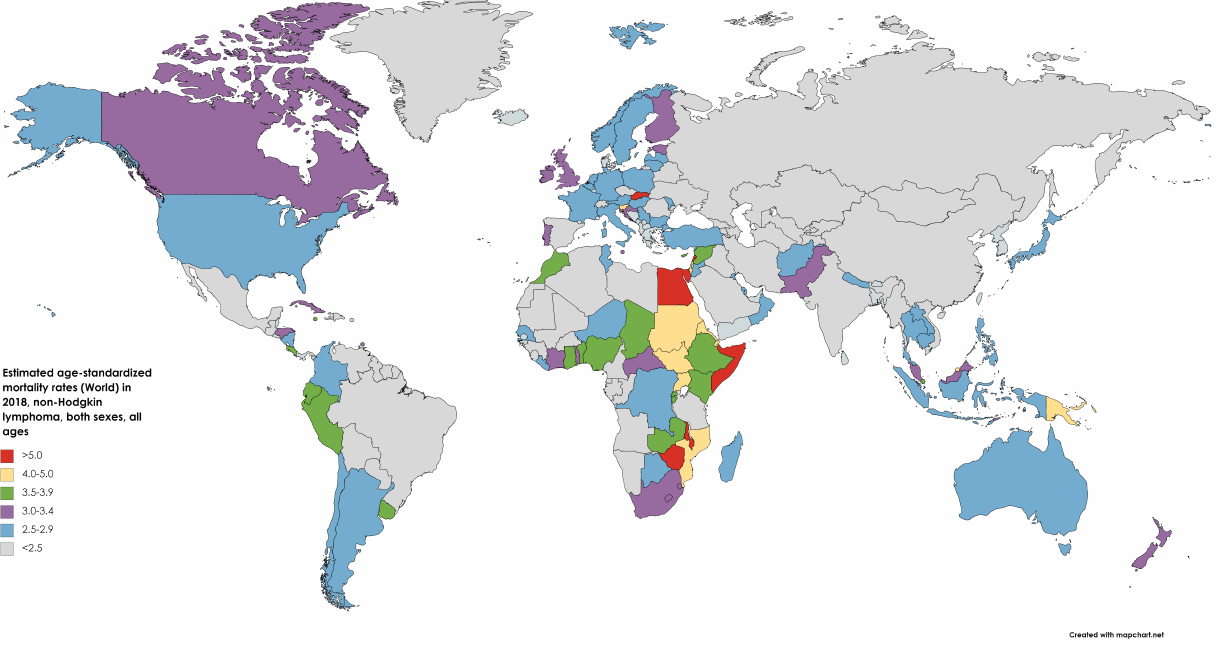
Figure 3. Map showing estimated age-standardized mortality rates (ASR) for non-Hodgkin’s lymphoma worldwide in 2018, all sexes, including all ages. Created with mapchart.net. Data obtained from Globocan 2018. The mortality in the US was an estimated 19,900 in 2020, accounting for 3.3% of all cancer deaths (making NHL the sixth leading cause of oncological mortality). The